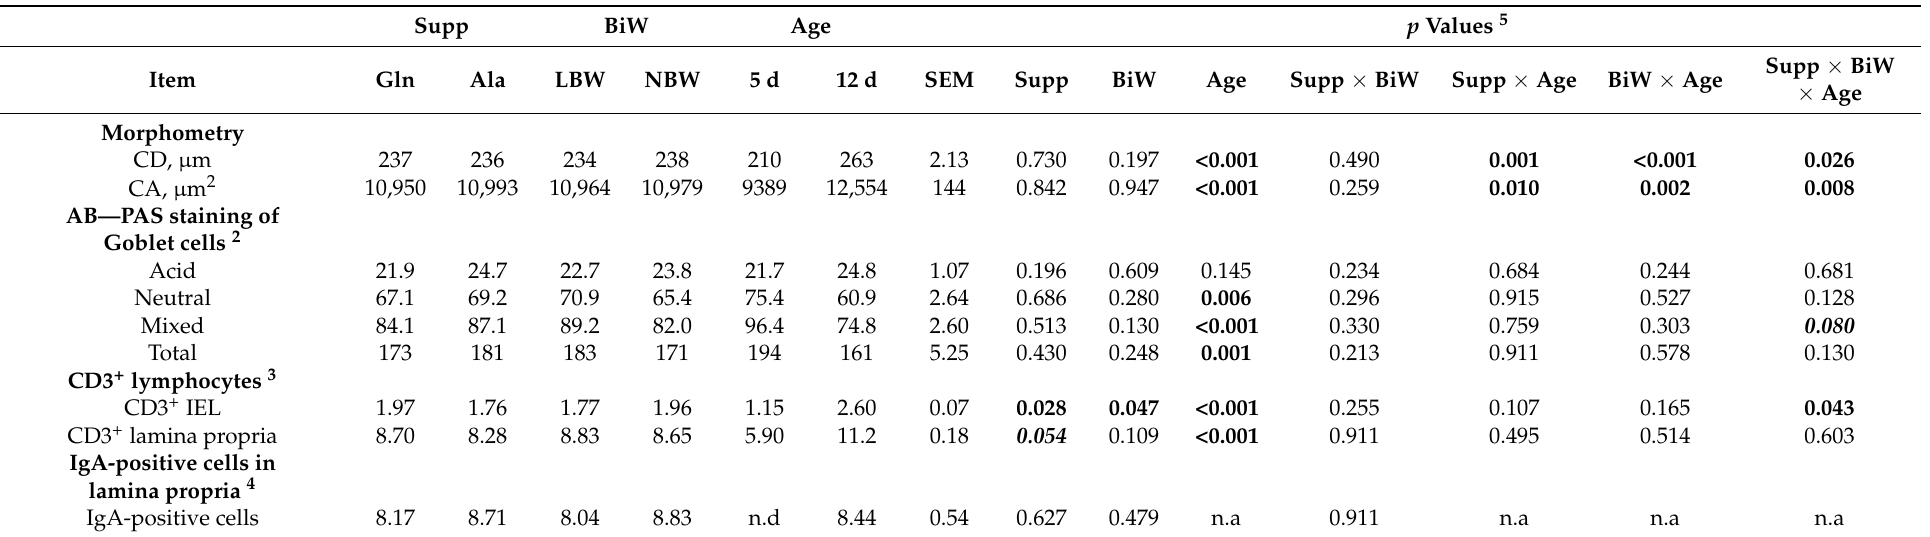
Table 1. Morphometric and immunohisto-morphometric measurements of the colon of 5- and 12-day-old male suckling piglets 1 . Supp BiW Age p Values